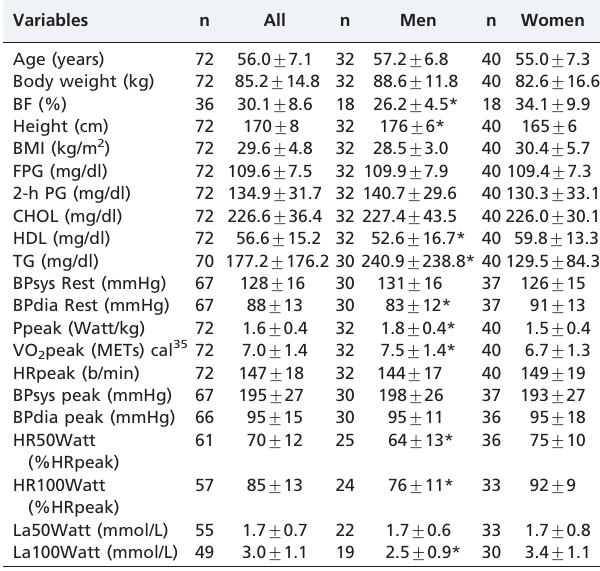
Table 1 - Baseline characteristics of the